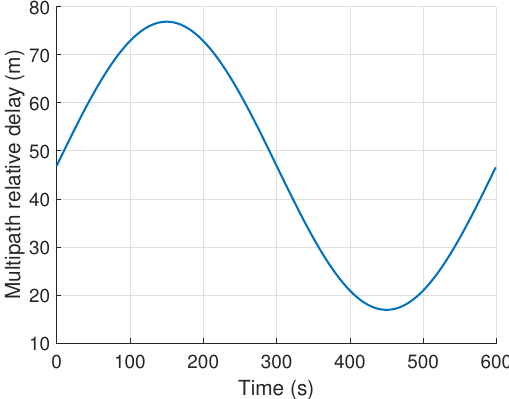
Figure 12. Variations of the multipath relative delay.